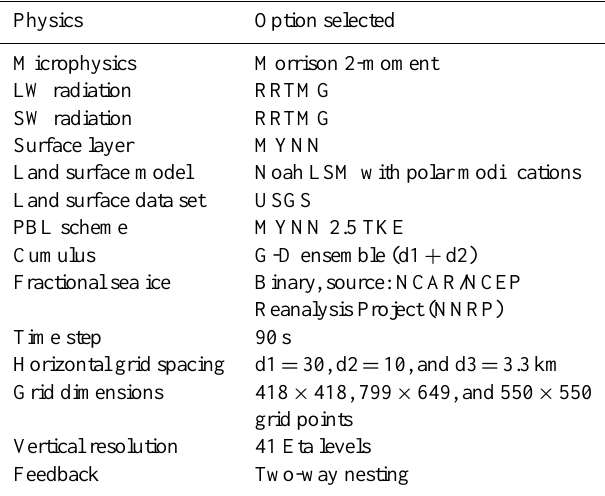
Table 1. CARVE 2012 WRF v3.4.1 configuration and physics op-